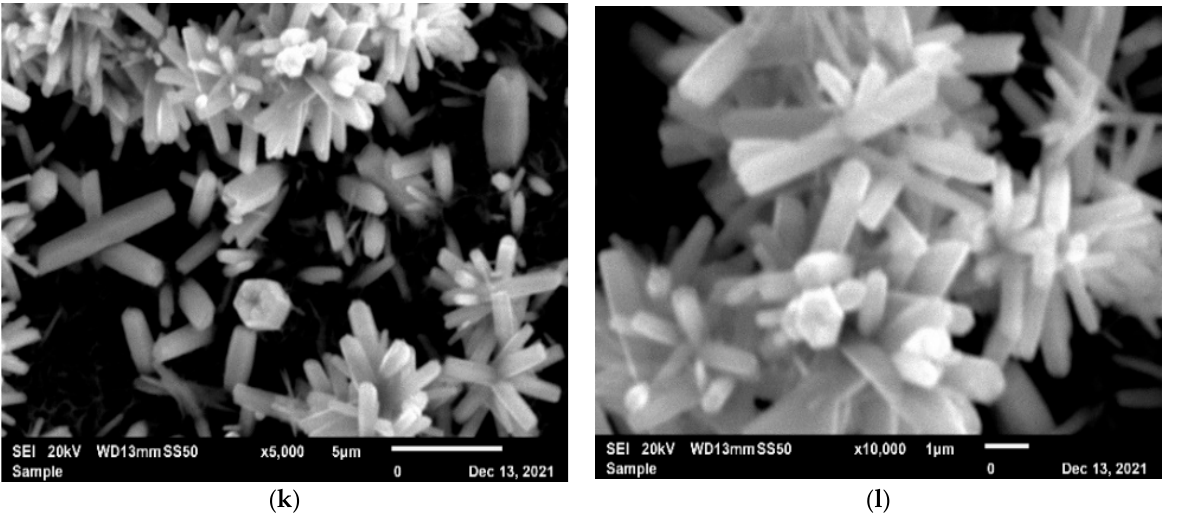
Figure 5. Scanning Electron Microscope (SEM) images of samples ( a,b ) Pure ZnO, ( c,d ) ZnO:Ag (2%) , ( e,f ) ZnO:Ag (4%) , ( g,h ) ZnO:Ag (6%) , ( i,j ) ZnO:Ag (8%) , and ( k,l ) ZnO:Ag (10%) synthesized by LACBS.